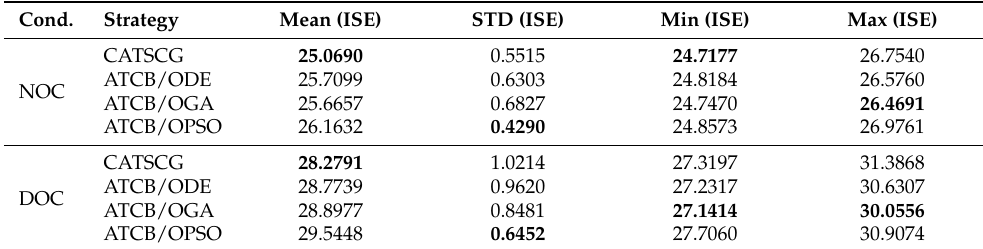
Table 4. Descriptive statistical